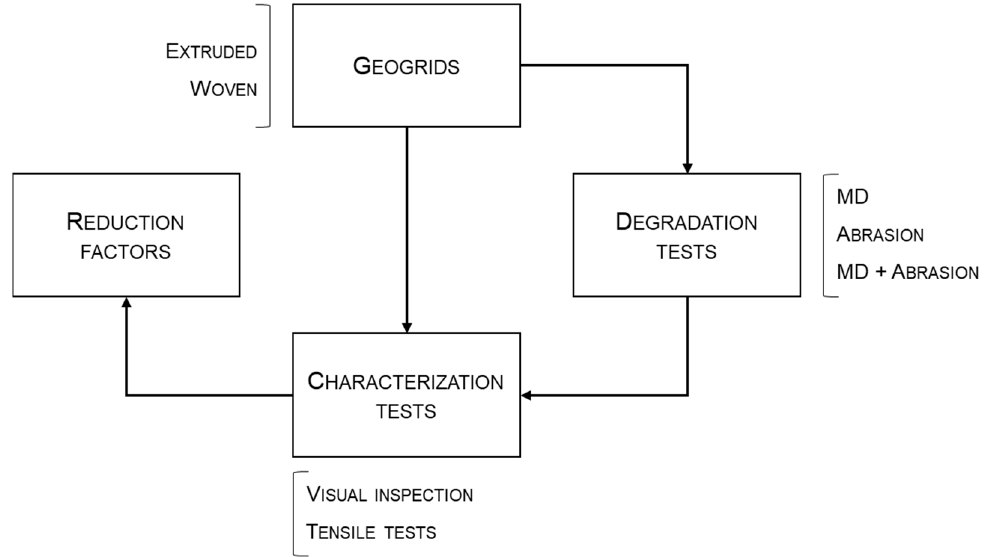
Figure 1. Structure of the experimental program. (MD—mechanical damage under repeated loading).